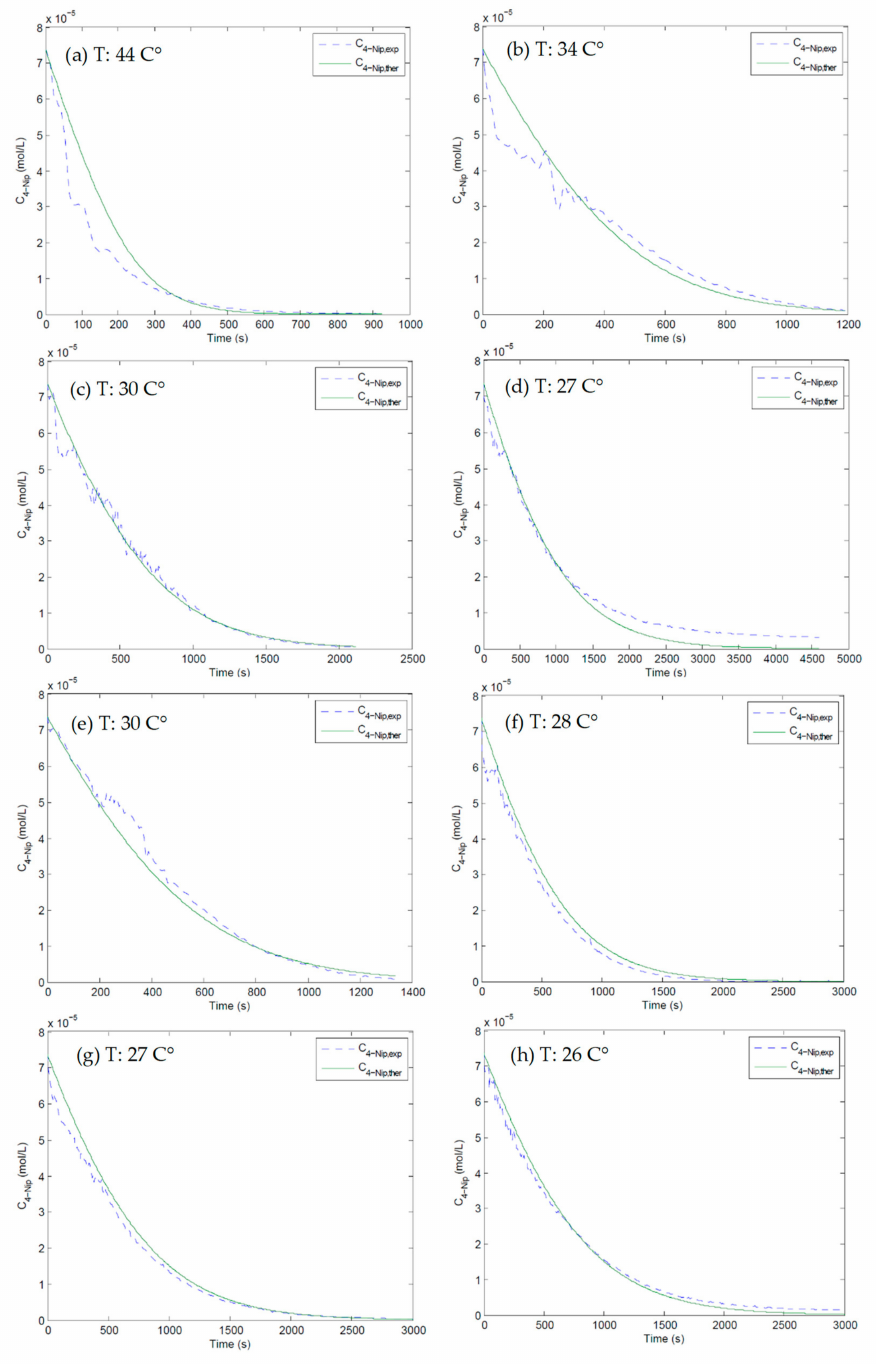
Figure 8. Plots of the concentration of 4-Nip as a function of time at di ff erent temperatures by using the Langmuir–Hinshelwood model. The solid green lines represent the respective fits to the kinetic model. The amount of BH 4 − used was 150 eq and 200 eq for graphs ( a – d ) and ( e – h ), respectively. The corresponding fit parameters are presented in Table 3. These parameters were determined using a numerical solution of Equation (1) by a MatLab routine. Apparently, a single set of the rate constant k and the adsorption constants K 4- Nip and K BH 4 − is able to represent the experimental data